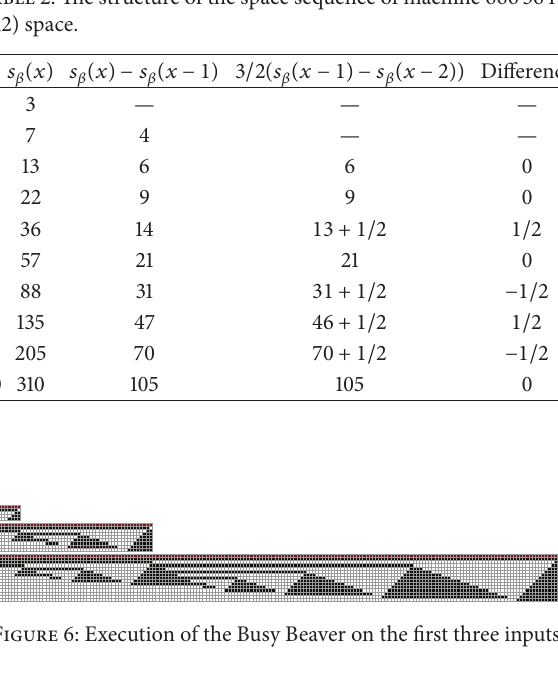
they have the exact same behavior and we will not distinguish between